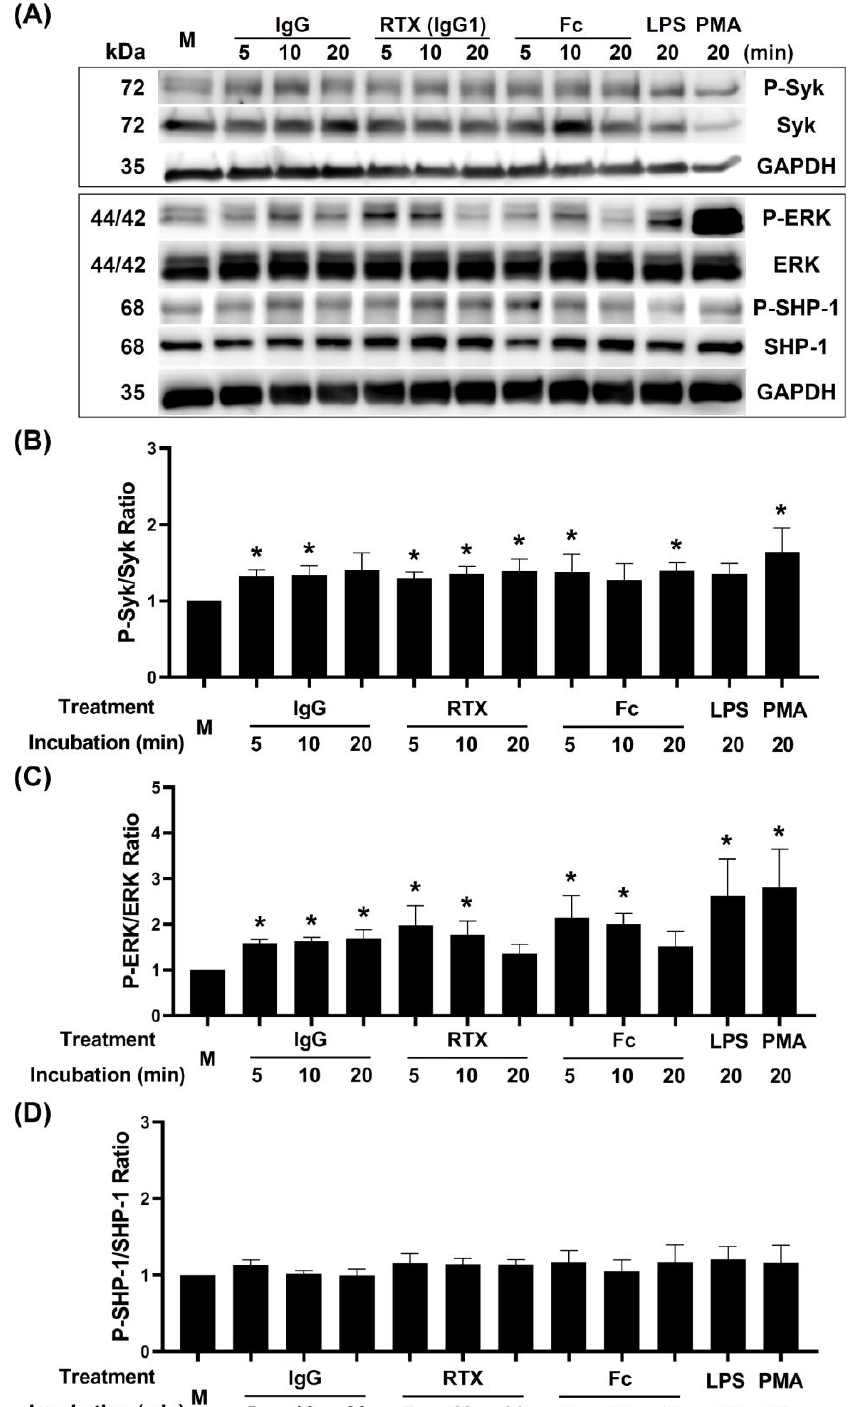
the phosphorylation of Syk-ERK, but not SHP, to transduce the Syk-ERK-NF- κ B interior signaling pathway.